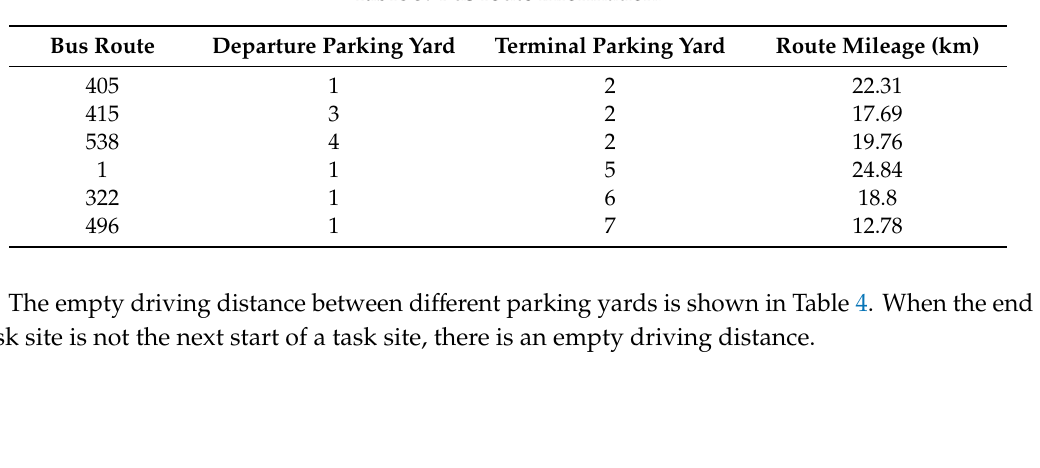
Table 3. Bus route